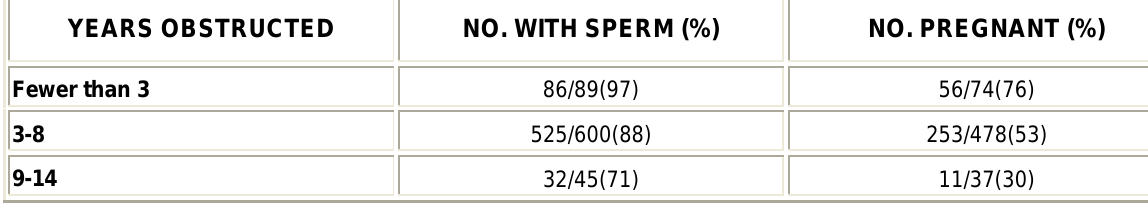
Obstuctive Interval vs. Postoperative Results After Vasectomy Reversal YEARS OBSTRUCTED NO. WITH SPERM (%) NO. PREGNANT (%) Fewer than 3